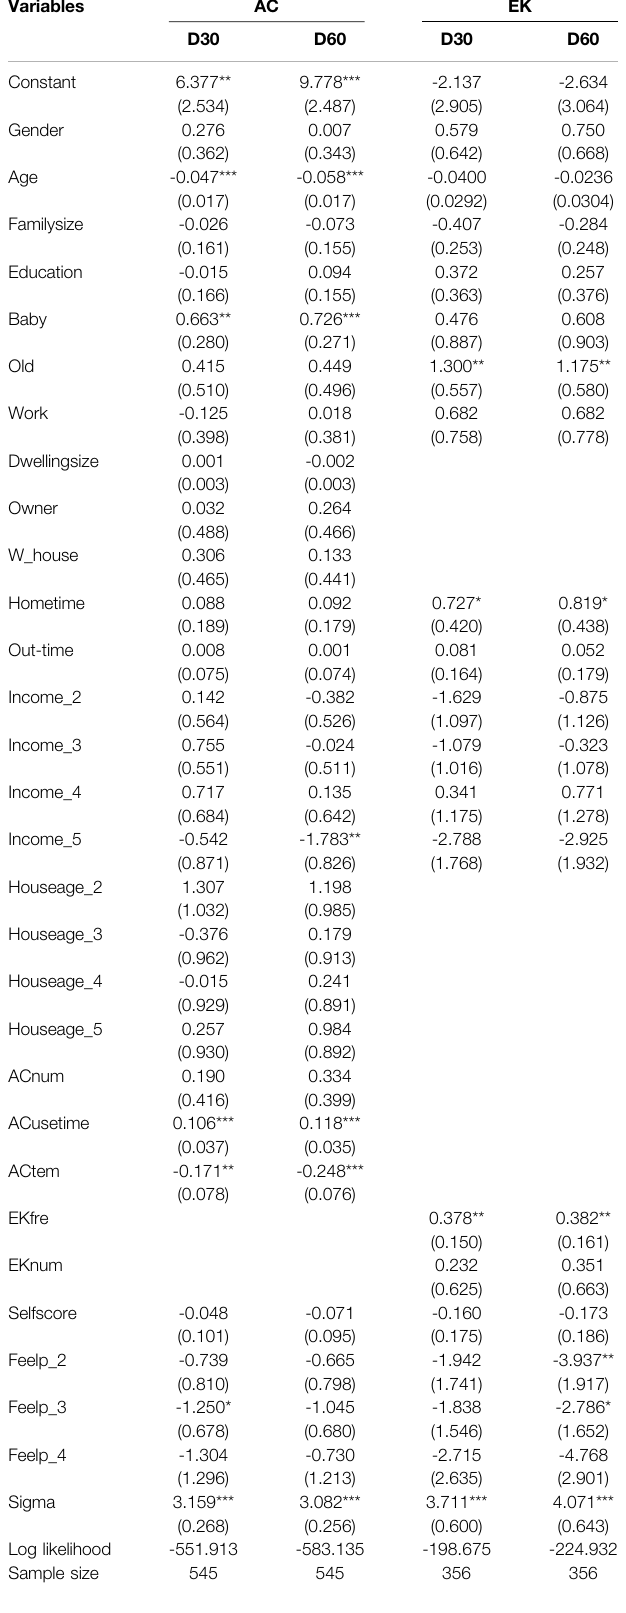
TABLE 4 | Estimation results of Model (3), under different interruption scenarios.